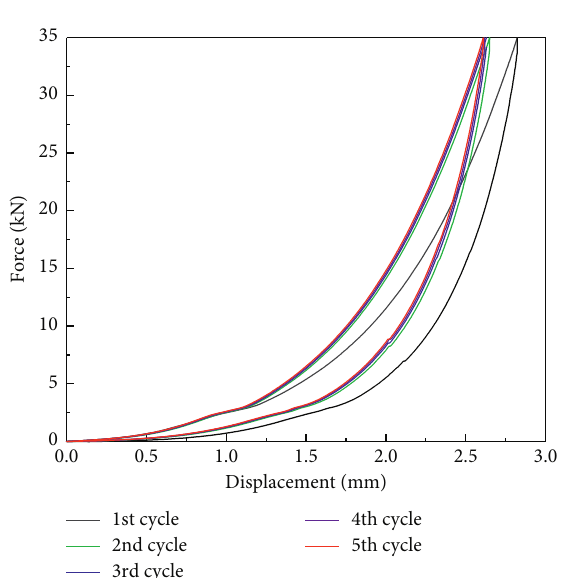
Figure 7: Cyclic force-displacement curves (EMWM-1, 25 ° C).